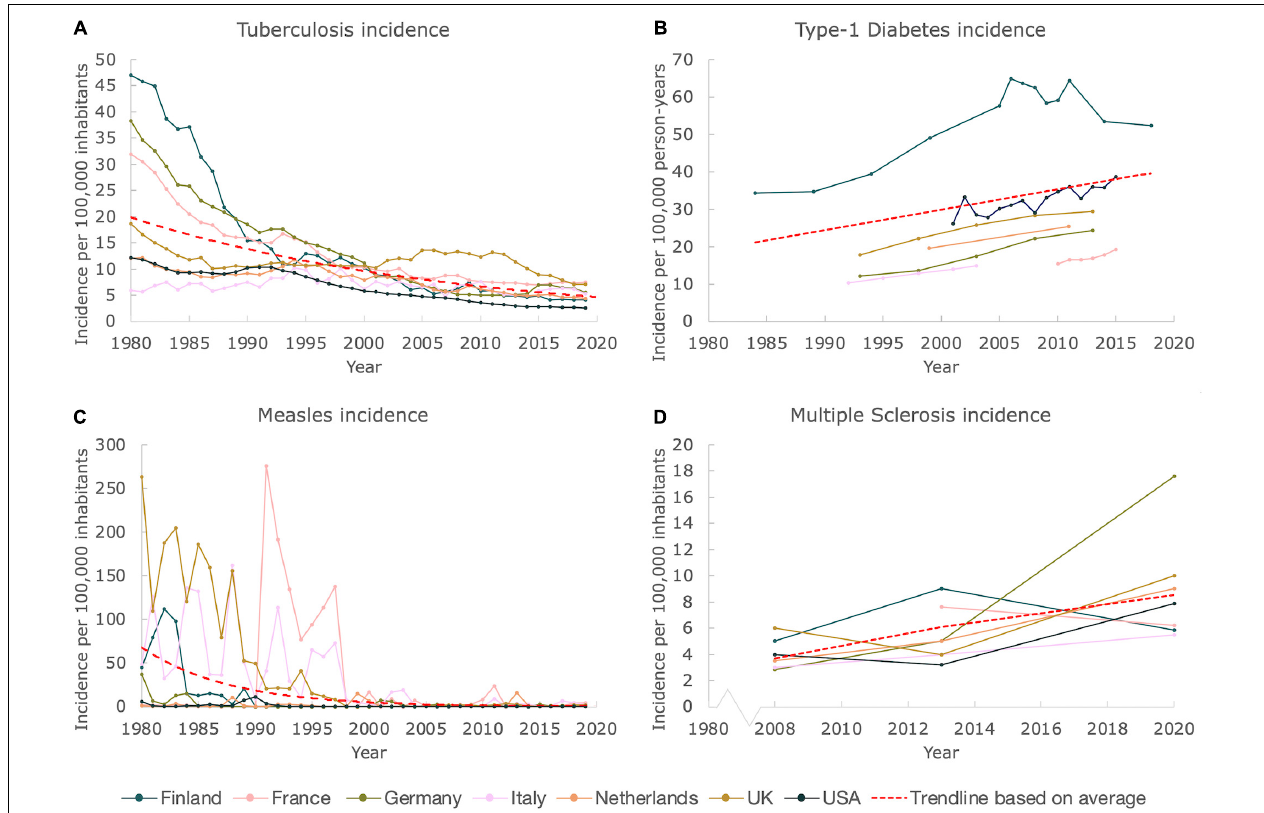
FIGURE 1 | While incidences of prototypical infectious diseases declined, incidences of autoimmune diseases increased. Figure shows incidences of prototypical infectious and autoimmune diseases for Finland, France, Germany, Italy, the Netherlands, United Kingdom and United States. The trendlines (exponential for TB and measles incidences, and linear for T1D and MS incidences) are based on the average values, and merely serve as a guide to the eye. A Mann Kendall Trend Test was performed for all figures (except for the data on MS due to the limited amount of data). The test showed significance: P < 0.05, for all incidences (except for the MS data, which did not allow a test to be performed). (A) The incidence of TB from 1980 until 2019. (B) The incidence of T1D from 1984 until 2018. (C) The incidence of measles from 1980 until 2019. (D) The incidence of MS from 2008 until 2020.